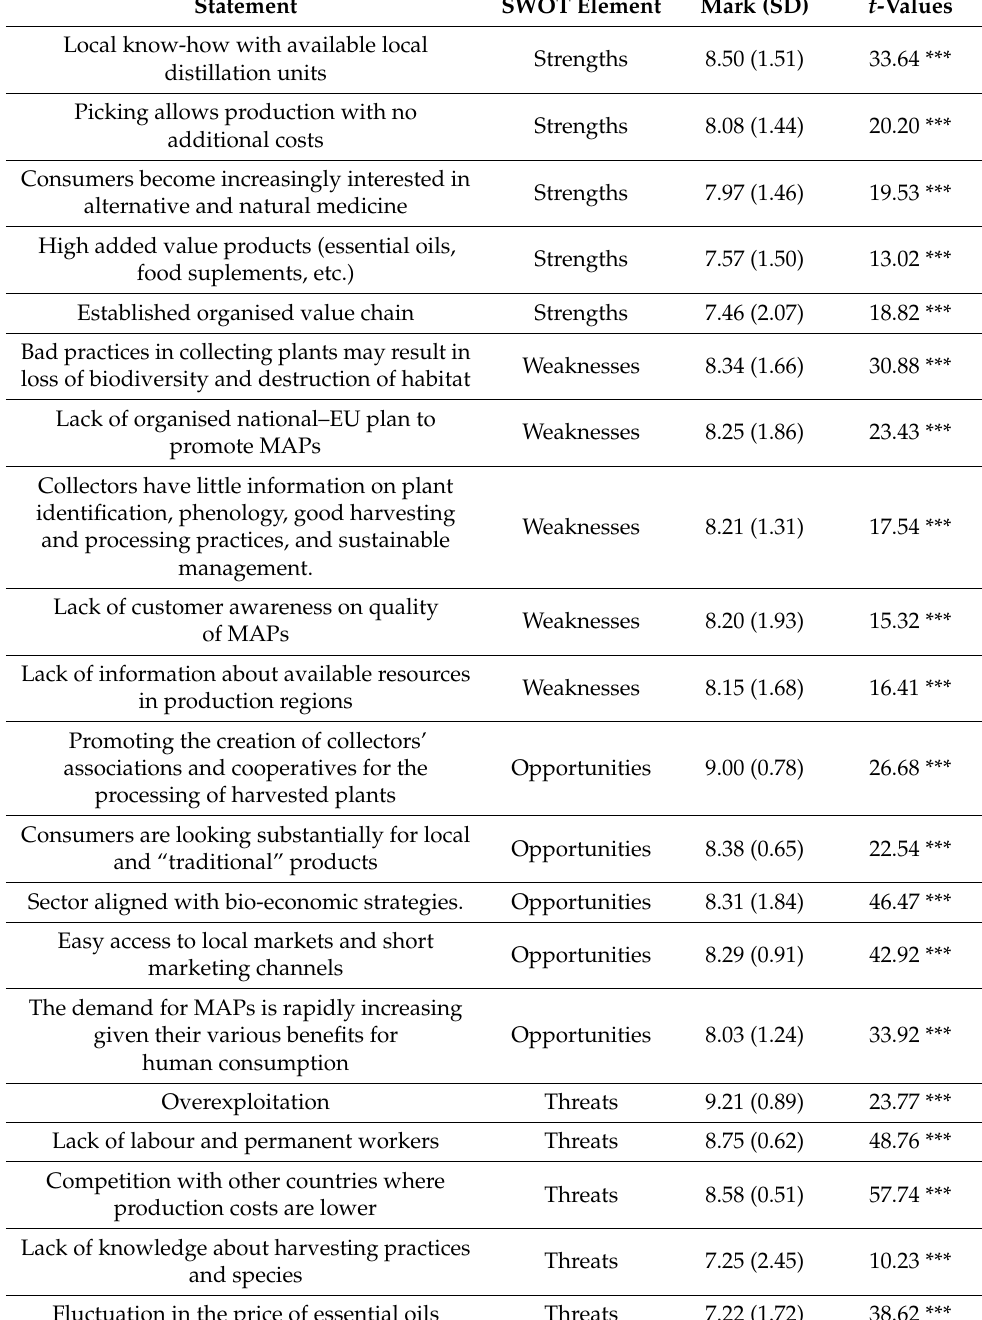
Table 1. Top five ranked strengths, weaknesses, opportunities, and threats identified by the MAPs expert panel at the end of the second